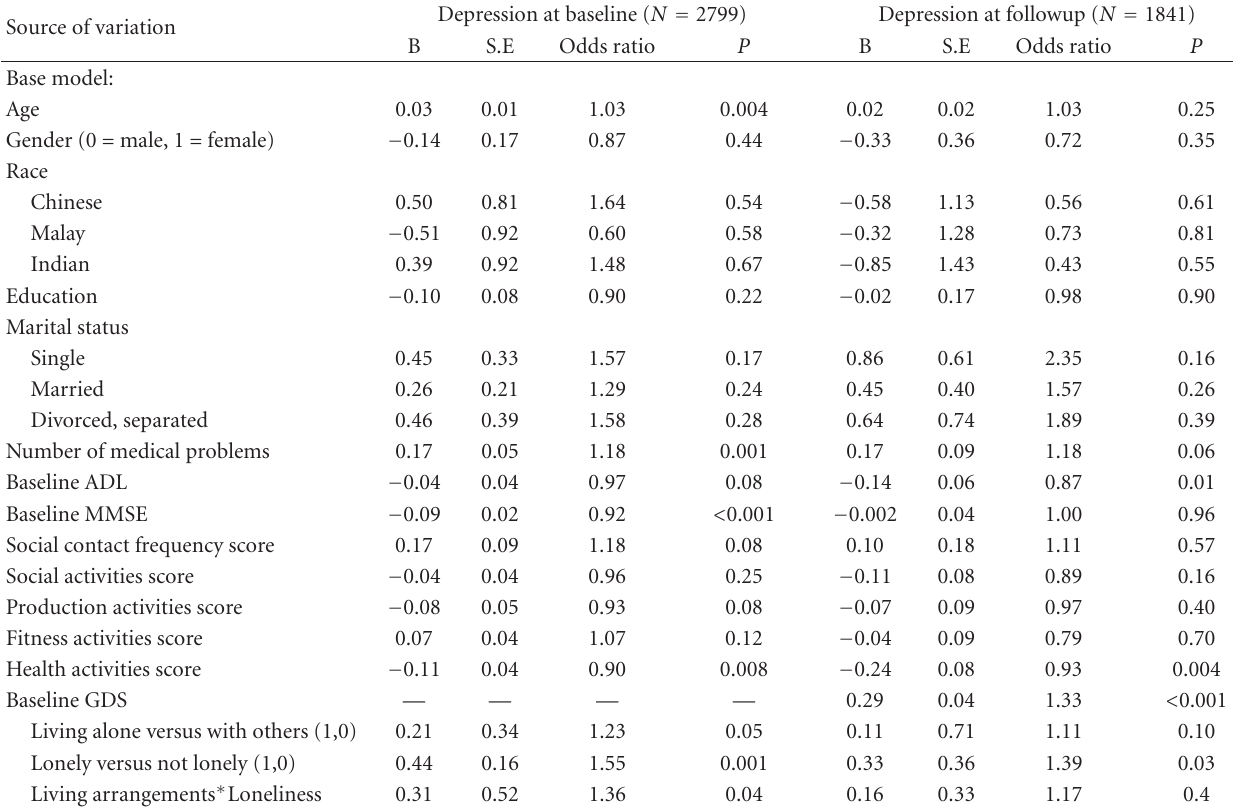
Table 4: Logistic regression predicting depression at baseline and